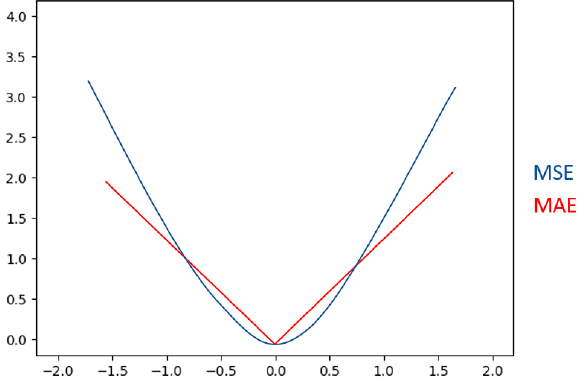
Figure 7. Difference between MSE and MAE.